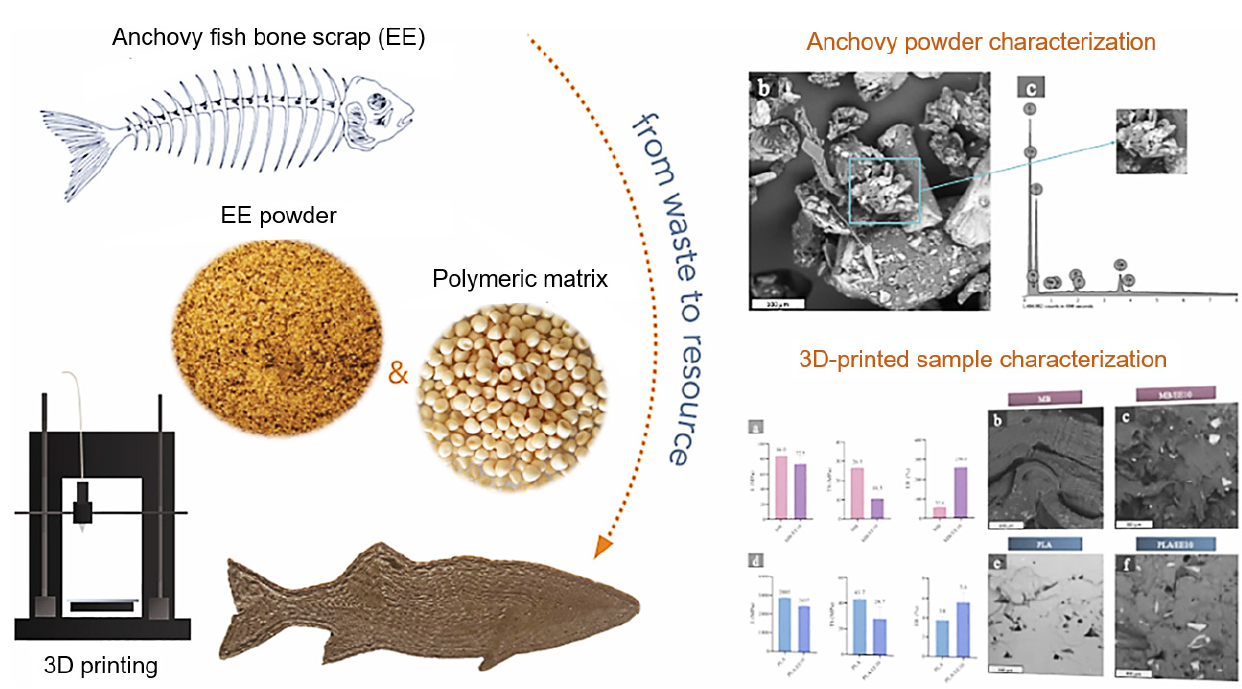
Figure 12. 3D-printed green composite filaments from fishbone waste with polylactic acid “Re- printed/adapted with permission from Ref. [72]. Copyright © 2022,